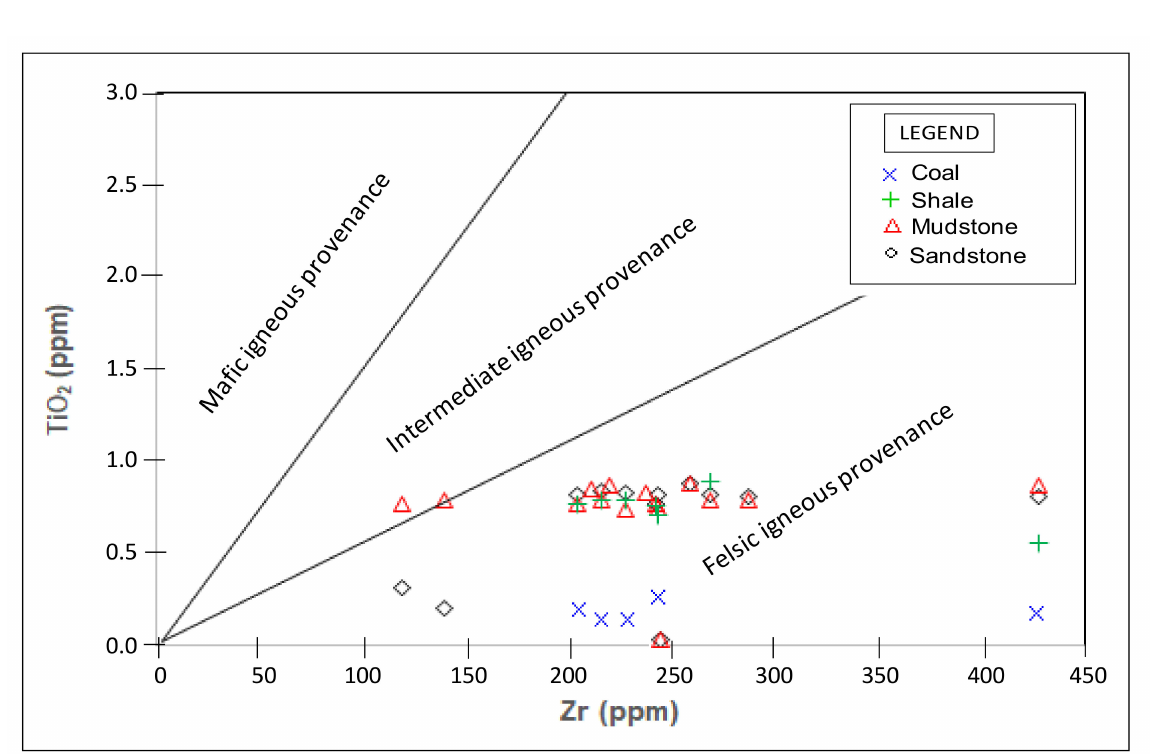
Figure 13. Binary plot of TiO 2 against Zr for the studied samples showing provenance (Background after [34]).